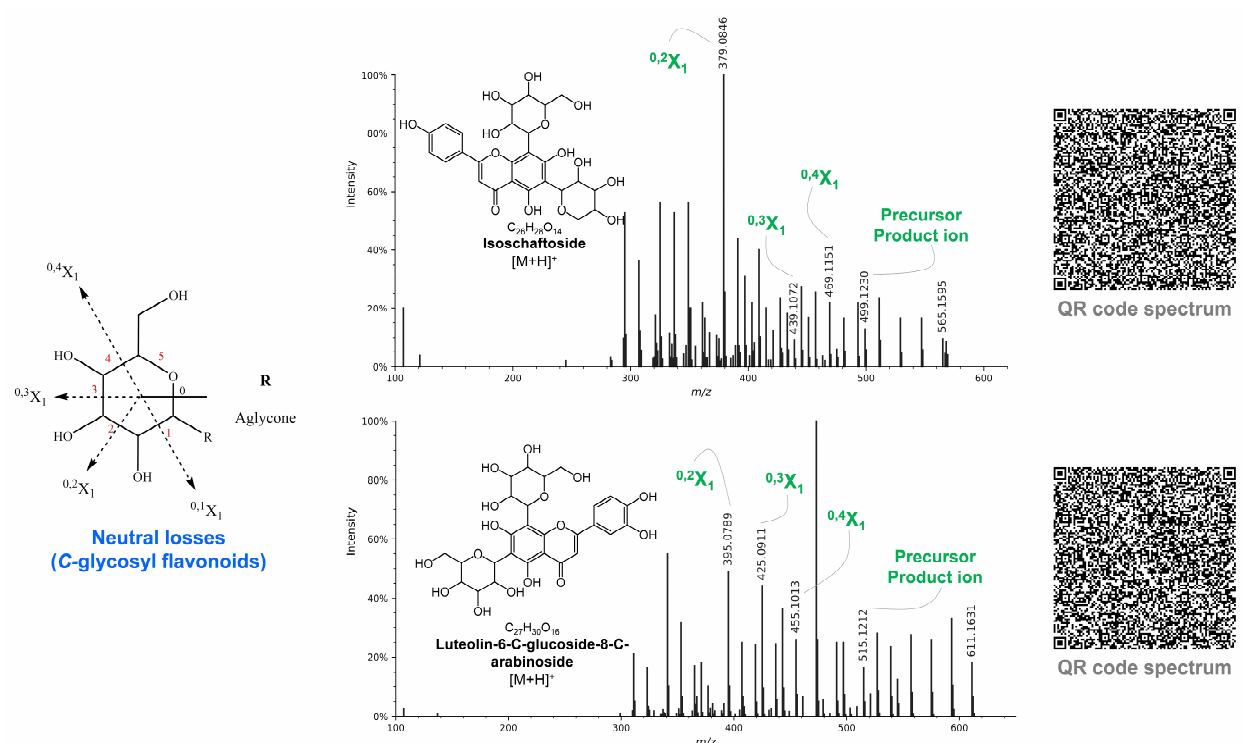
Figure 2. Characteristic losses of portions of hexose in flavonoids (e.g., MS/MS spectrum to Isoschaftoside and Luteolin-6- C -glucoside-8- C -arabinoside). Both mass spectra are available by QR code.